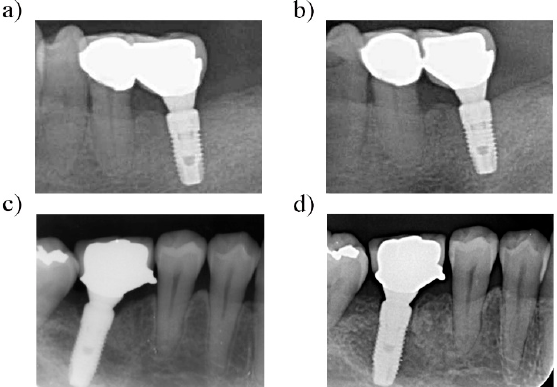
Figure 3. Radiographic follow-up images of dental implants. ( a ) Platform-switched dental implant in lower left area immediately after prosthetic delivery. ( b ) Radiographic view of the same dental implant in the lower left area at a three-year follow-up, with no apparent bone remodeling. ( c ) Platform-switched dental implant in the lower right area immediately after prosthetic delivery, ( d ) Radiographic view of the same dental implant in lower right area at three-year follow-up, with minimal bone remodeling. The mean level of the vertical marginal bone before loading the PS implants was 1.74 ± 1.32 Table 1. Demographic Information.